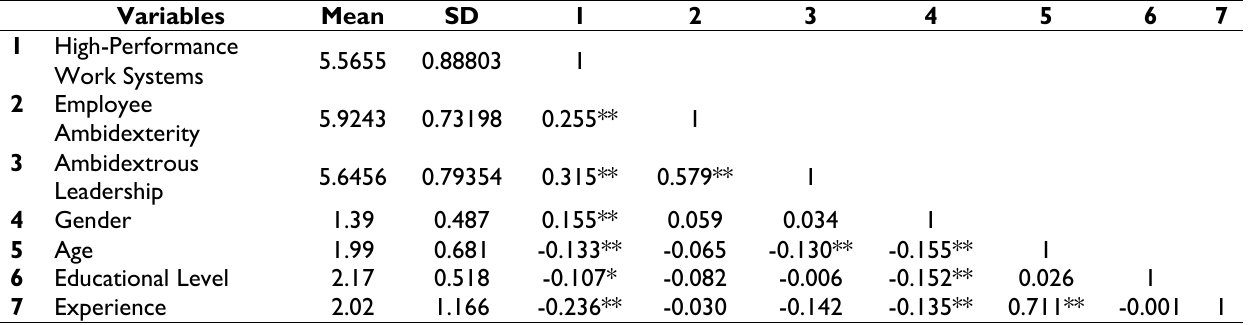
Table 2. Mean, Standard Deviation, and Correlations among the Study